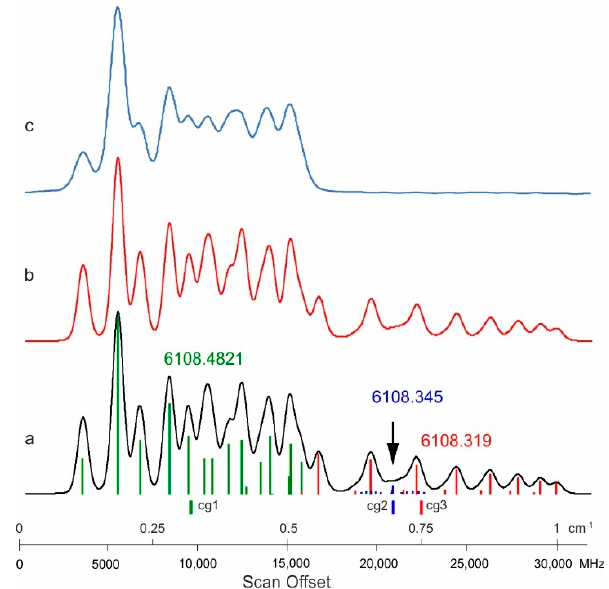
Figure 3. Part of the spectrum between 6108.60 and 6108.21 Å showing the lines at 6108.4821, 6108.319, and 6108.435 Å. (a) Optogalvanic (OG) record. (b) Fit. (c) Corresponding part of the Fourier-transform and 6108.435 Å. ( a ) Optogalvanic (OG) record. ( b ) Fit. ( c ) Corresponding part of the Fourier-transform (FT) spectrum. See text for description. (FT) spectrum. See text for